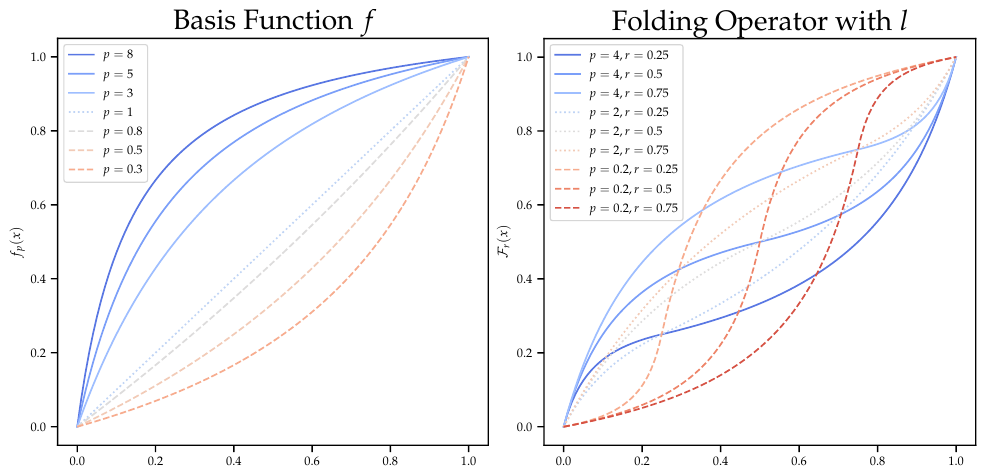
Figure 4. ( Left ): different examples of the linear transformation l p with different values of p . ( Right ): examples of folding operators with varying values of p and r